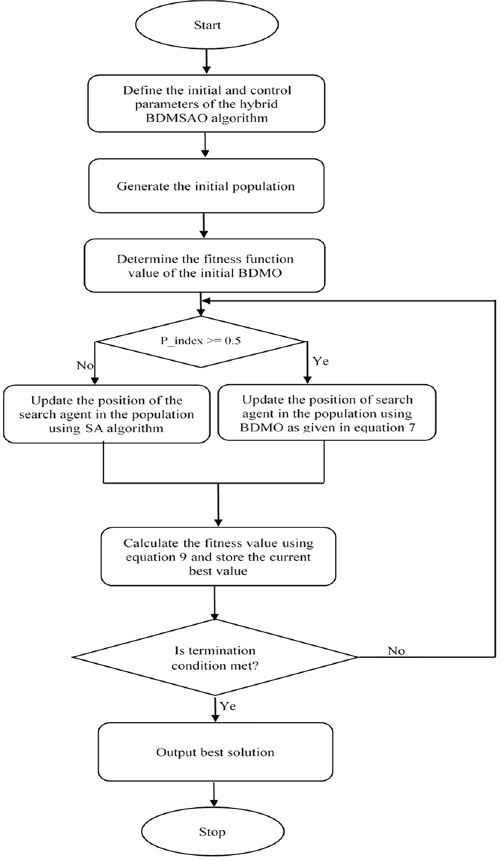
Figure 1. Flowchart illustrating the algorithmic structure of the BDMSAO